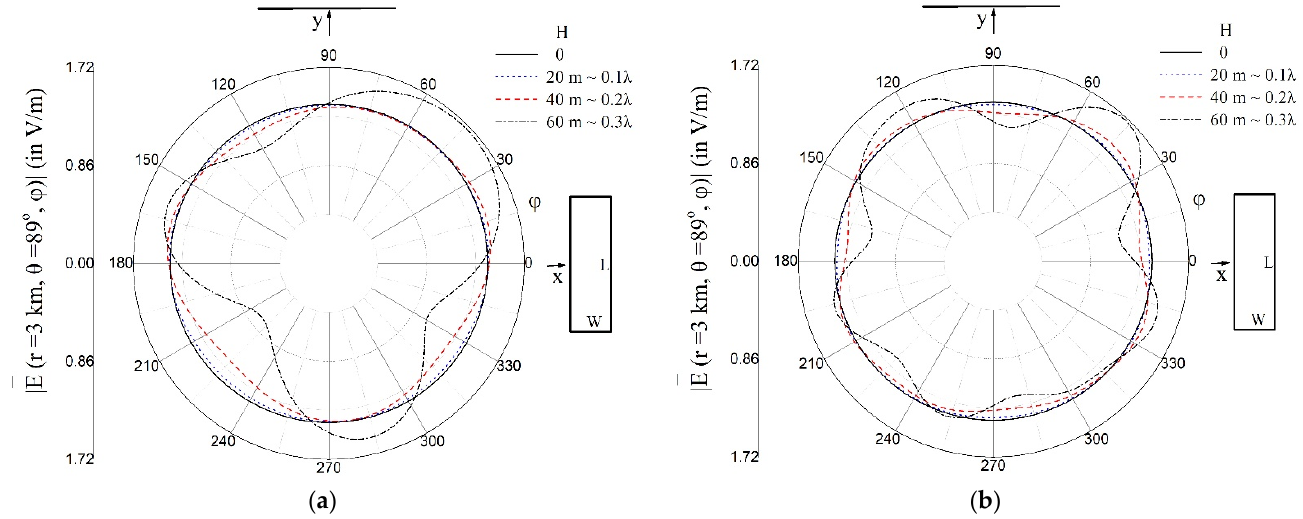
Figure 8. θ -plane of the radiation patterns of the monopole in free space (black, solid curve) and in the presence of two buildings 30 × 10 × H m 3 . Three different heights H are considered (dashed and dotted curves, as indicated at the upper right corner). The distances between the antenna and each building are ( a ) R = 100 m ≈ 0.5 λ and ( b ) R = 200 m ≈ λ